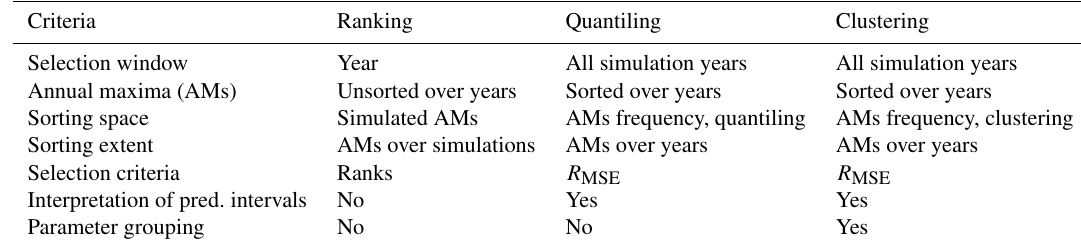
Table 1. Comparison of three methods for selecting representative parameter sets based on annual maxima (AMs). Criteria Ranking Quantiling Clustering Selection window Year All simulation years All simulation years Sorted over years Sorted over years Simulated